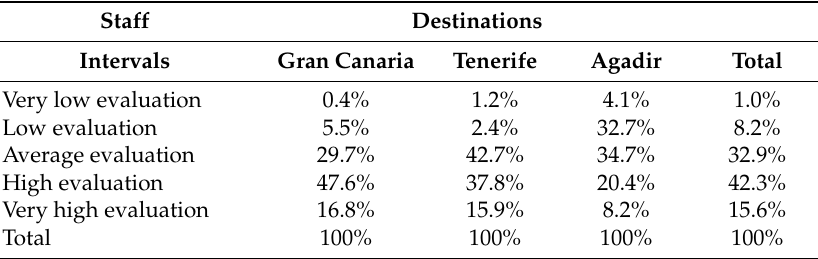
Table 6. Comparative analysis of the staff variable.